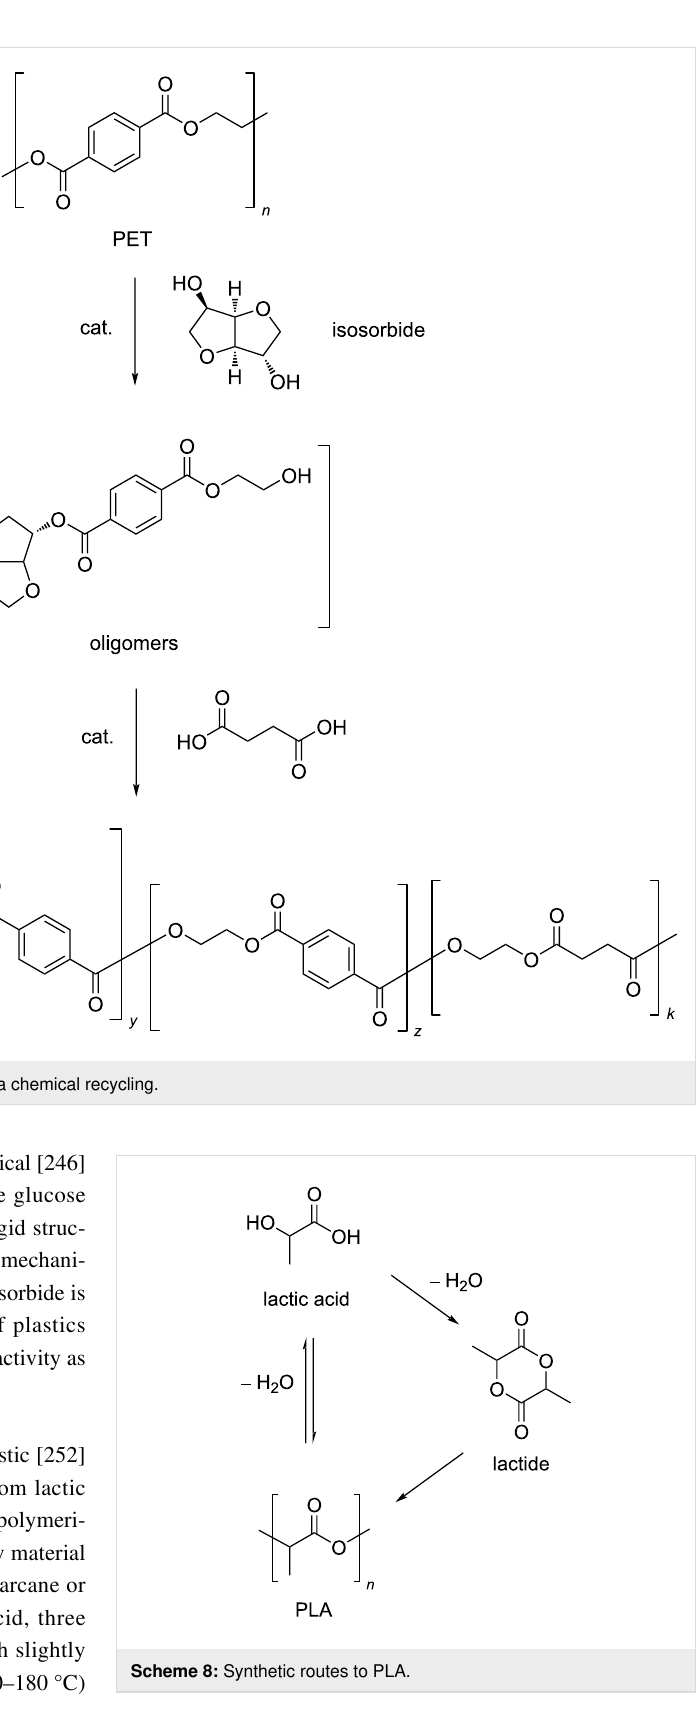
Scheme 8: Synthetic routes to